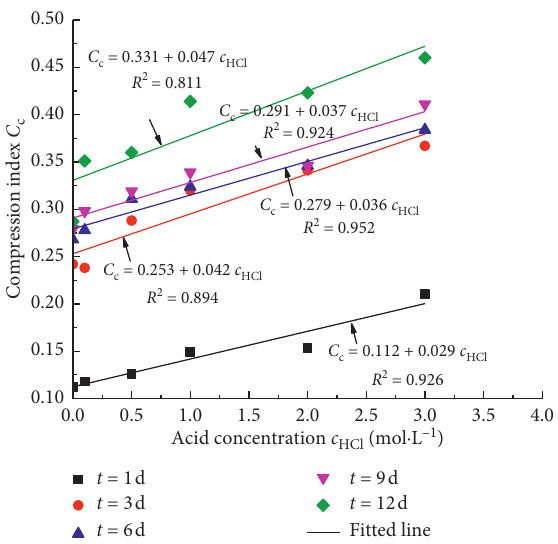
Figure 4: Variation in compression index values with acid